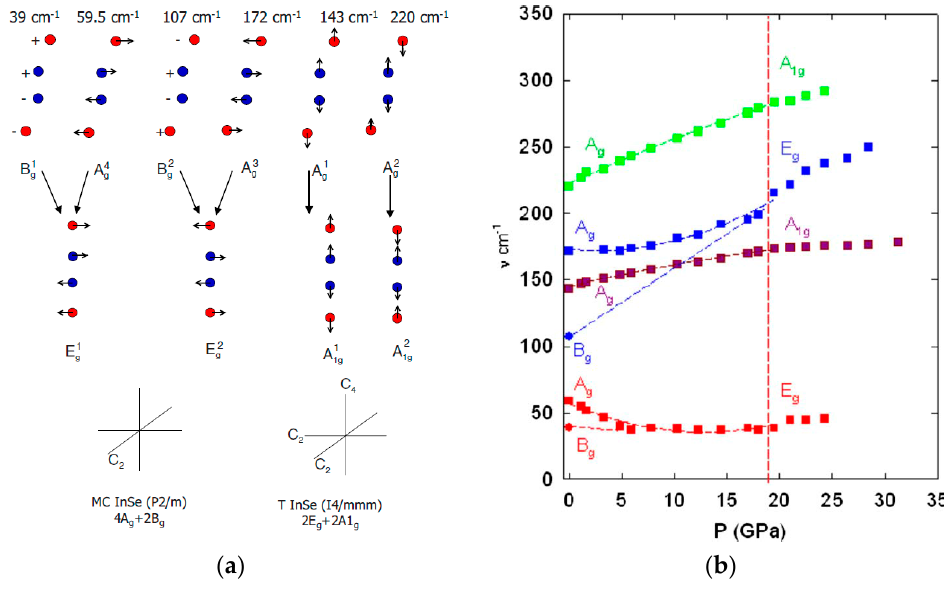
Figure 17. Phonon modes in MC- and T-InSe. ( a ) Vibration schemes of Raman active modes at the Γ point. ( b ) Pressure dependence of the normal modes frequencies [30].